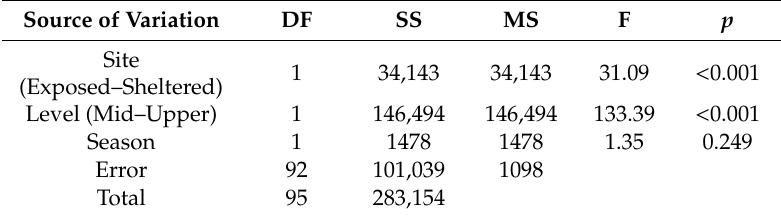
Table 4. ANOVA General Linear model results of spatial and temporal e ff ects, degrees of freedom (DF), sum of squares (SS), mean squares (MS), on the surveyed C. stellatus population abundance. Source of Variation DF SS MS F p